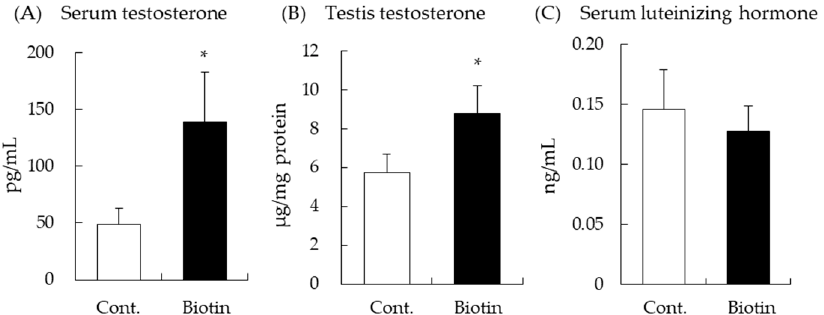
Figure 1. Intraperitoneally administered biotin increases testosterone production in BALB/c mice. Testosterone levels in serum ( A ) and testis ( B ), and serum luteinizing hormone levels ( C ) were measured by ELISA. Data are presented as mean ± standard error (n = 4–7). * p ≤ 0.05, vs. control (Cont.) group, Student’s t -test.